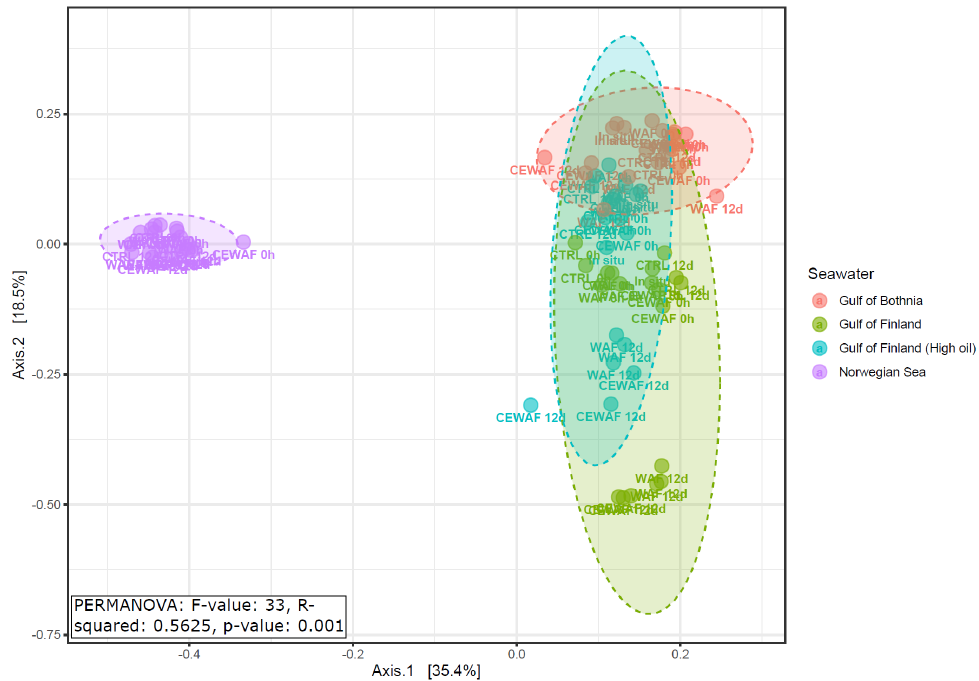
Figure 5. Principal coordinates analysis (PCoA) of microbial communities comparing different microcosm experiments. PCoA was based on a Bray–Curtis distance matrix using genera data. Ordination of samples on the PCoA plot indicates that the within-group variation was smallest in the case of Norwegian Sea bacterial communities, while the Baltic Sea samples, especially from the Gulf of Finland, varied along the PCoA second